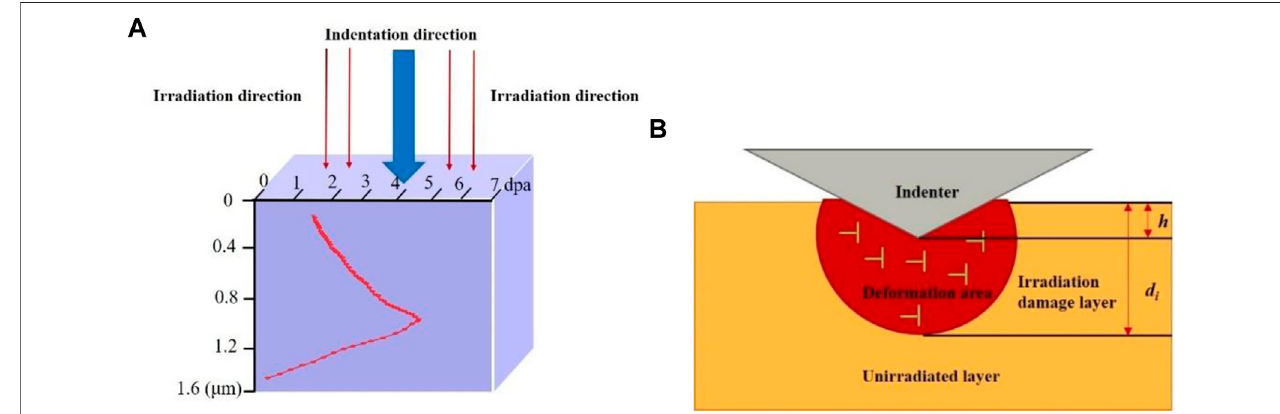
FIGURE2|(A) IrradiationandindentationdirectionoftheF321austeniticstainless-steelspecimen,and (B) schematicdiagramofnanoindentationexperimentwith critical indentation depth (the area of deformation caused by the indenter being pressed into the substrate is located in the irradiation damage layer).